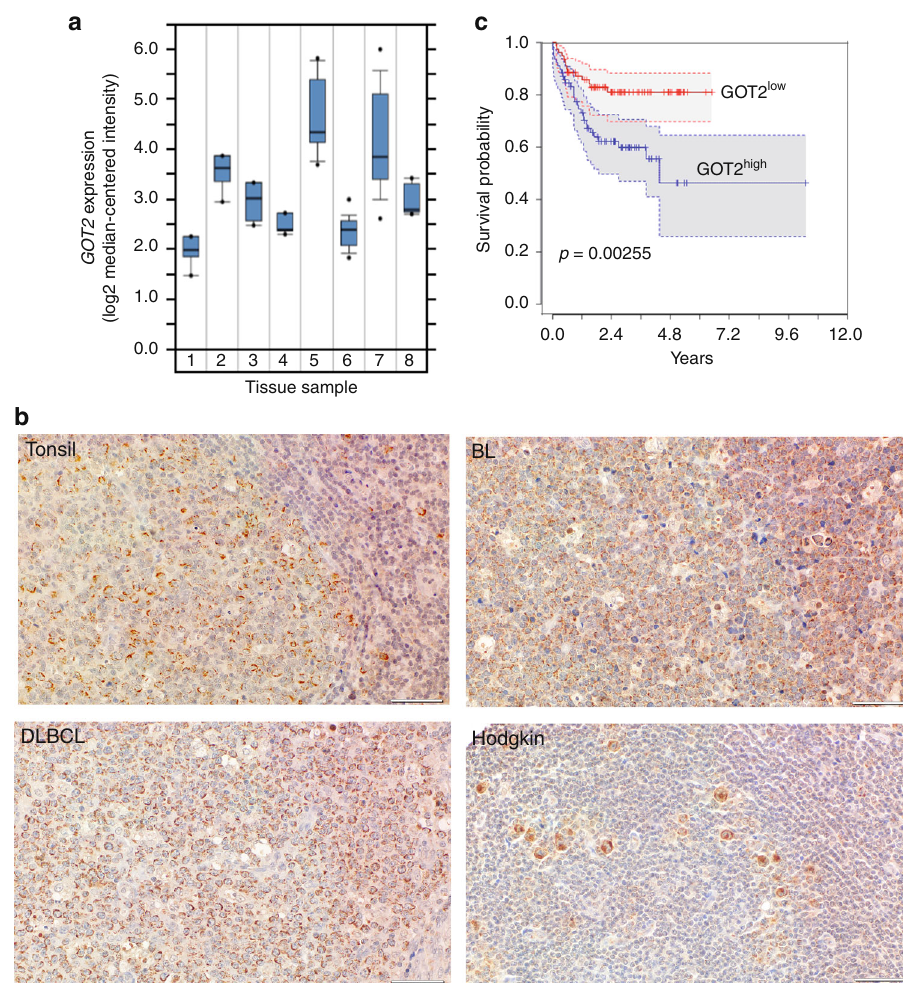
Fig. 7 GOT2 is overexpressed in lymphoma subtypes and correlates with worse overall survival in DLBCL patients. a Microarray gene expression data of GOT2 obtained at ONCOMINE 68,69 . Expression of normal B-cell controls (1 = B lymphocytes ( n = 5), 2 = centroblasts ( n = 5), 3 = memory B -cells ( n = 5), 4 = naive pre-germinal B- cells ( n = 5)), and lymphoma samples (5 = BL ( n = 17), 6 = CLL ( n = 34), 7 = DLBCL ( n = 32), and 8 = MCL ( n = 8)) are given. Boxes are showing median (middle line), upper and lower quantile (edges), minimum and maximum (bars), and outliners (dots). b Immunohistological staining of GOT2 in representative samples of tonsils, BLs, DLBCLs, and HLs (see also Table 1). The scale bar represents 50 µ m. In Supplementary Fig. 12, a corresponding GOT2 staining for the liver, lung, muscles, and skin is provided showing a homogeneous GOT2 expression in hepatocytes. c Kaplan – Meier curves of DLBCL patients ( n = 157) treated with R-CHOP 18 . Patients were grouped according to their GOT2 expression relative to the median of the group (high > median and low ≤ median). Additional details using a Cox proportional hazards regression model to estimate the clinical outcome of patients with DLBCL in relation to the expression of GOT2 are presented within Supplementary Table